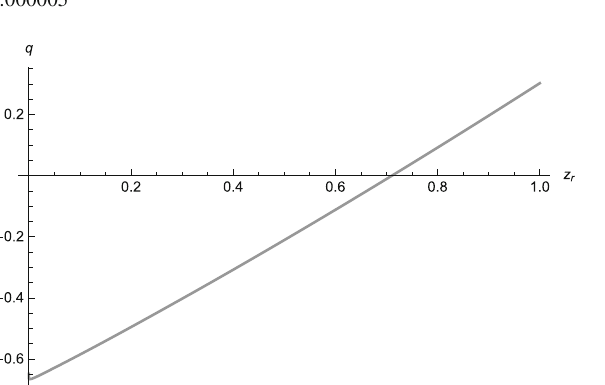
Fig. 17 The graphical behaviour of q ( z r ) over z r with γ = 1 E 25 = 0 . 69, E 26 = 2 . 42 E 24 and α 2 = 3 .